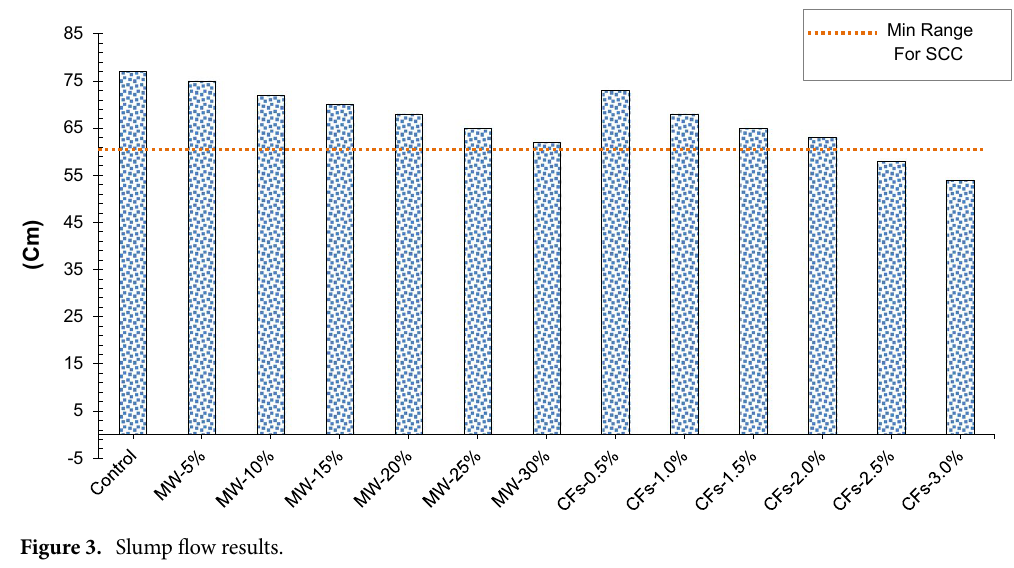
Figure 3. Slump flow results.